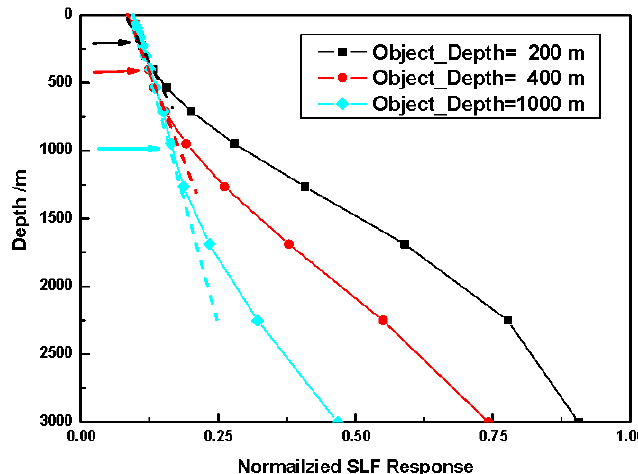
Figure 3. Three-layer model and theoretical responses using semi-quantitative frequency-depth transformation. The SLF responses in the depth domain (the second objective layers’ top depths) are set as 200 m, 400 m and 1000 m. Different dotted lines represent the trend lines. The arrows are located at the intersection points of trend lines of the SLF responses.